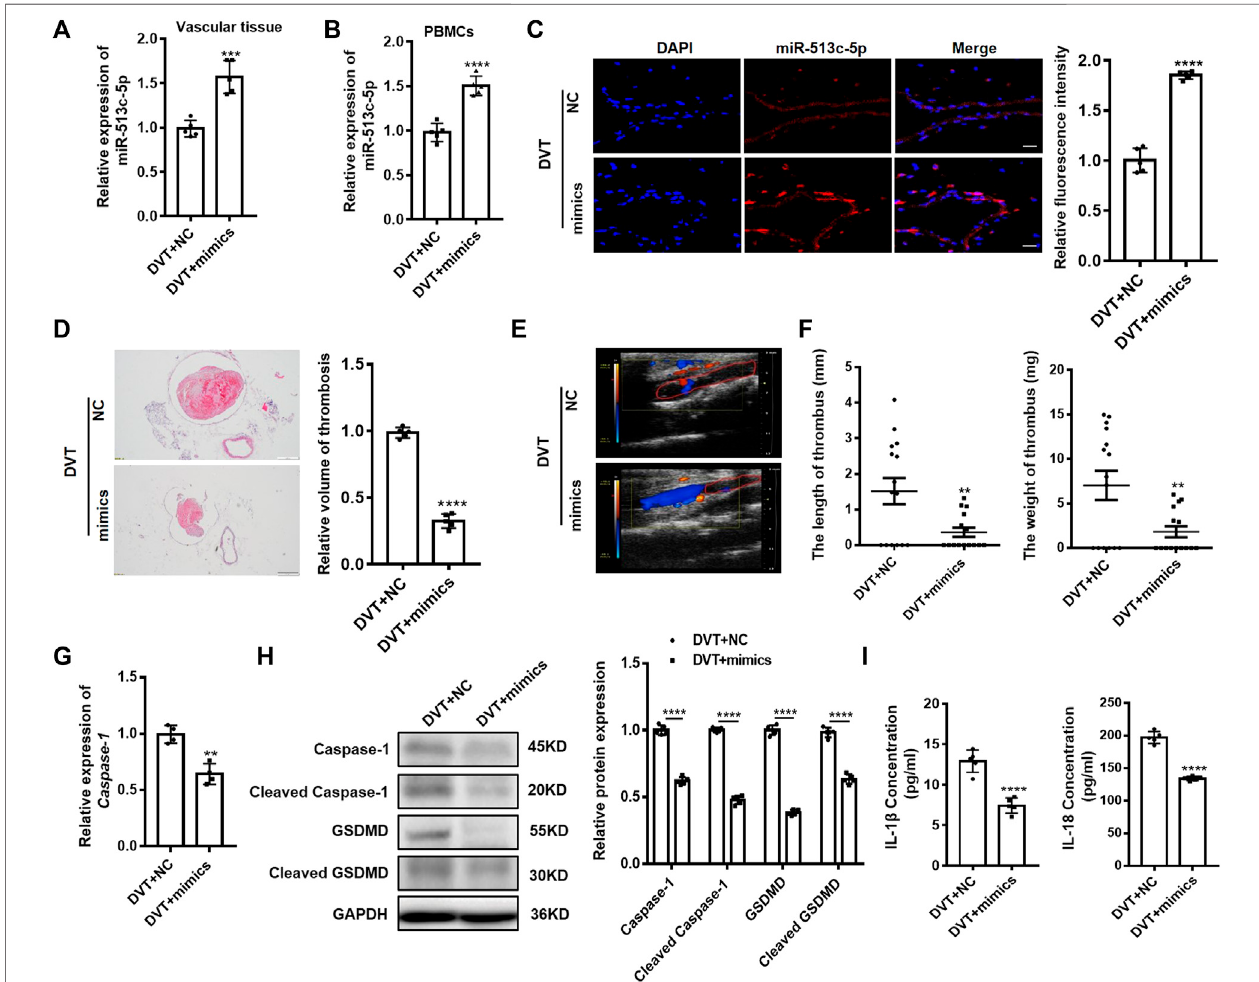
FIGURE 7 | Overexpression of miR-513c-5p suppresses pyroptosis of VECs and DVT formation by inhibiting caspase-1. (A) Expression of miR-513c-5p in vascular tissue was detected by qRT-PCR in DVT mice treated with NC, miR-513c-5p mimics, respectively. (B) Relative expression of miR-513c-5p was measured by qRT-PCR in PBMCs of DVT each treatment group. (C) Confocal microscopy images of miR-513c-5p expression in vascular tissues (miR-513c-5p, red; DAPI, blue) (magni fi cation, ×200). Scale bars = 100 μ m. (D) H&E staining of serial cross sections of inferior vena cava (IVC) from DVT mice treated with NC, miR-513c-5p mimics at 48 h (magni fi cation, ×40), respectively. Scale bars = 500 μ m. (E) Representative images of thrombi in each treatment group were detected by vascular ultrasound at 48 h post-operation. (F) Thrombus length and weight at 48 h post-operation in DVT mice ( n = 15) treated with NC, miR-513c-5p mimics. (G) Caspase-1 mRNA level was determined by qRT-PCR in vascular tissue of each treatment group. (H) Caspase-1 and GSDMD protein levels were determined by Western blot in vascular tissue of DVT each treatment group. (I) IL-1 β and IL-18 protein levels in vascular tissue were determined by ELISA in DVT each treatment group. ** p < 0.01, *** p < 0.001, and **** p <